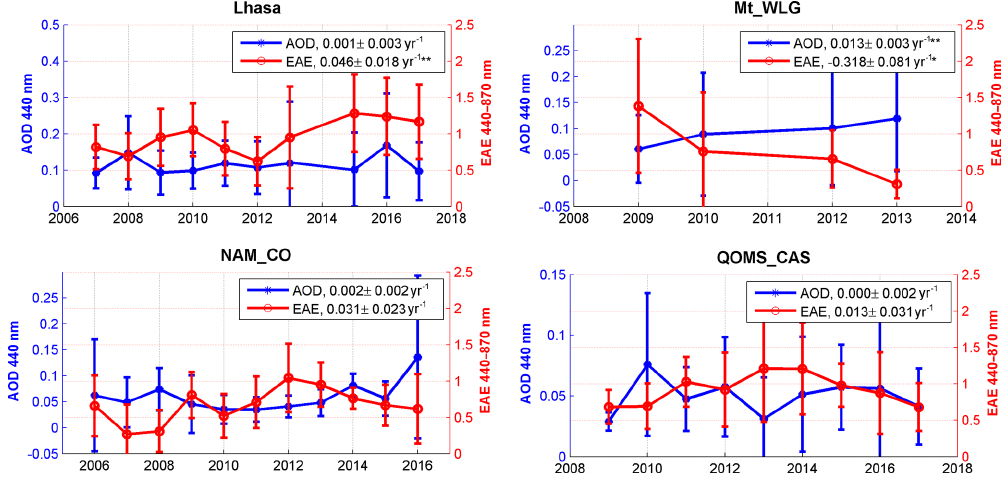
Figure 4. Annual averages of and trends in AOD and EAE from CE318 at four sites located in the Tibetan Plateau.